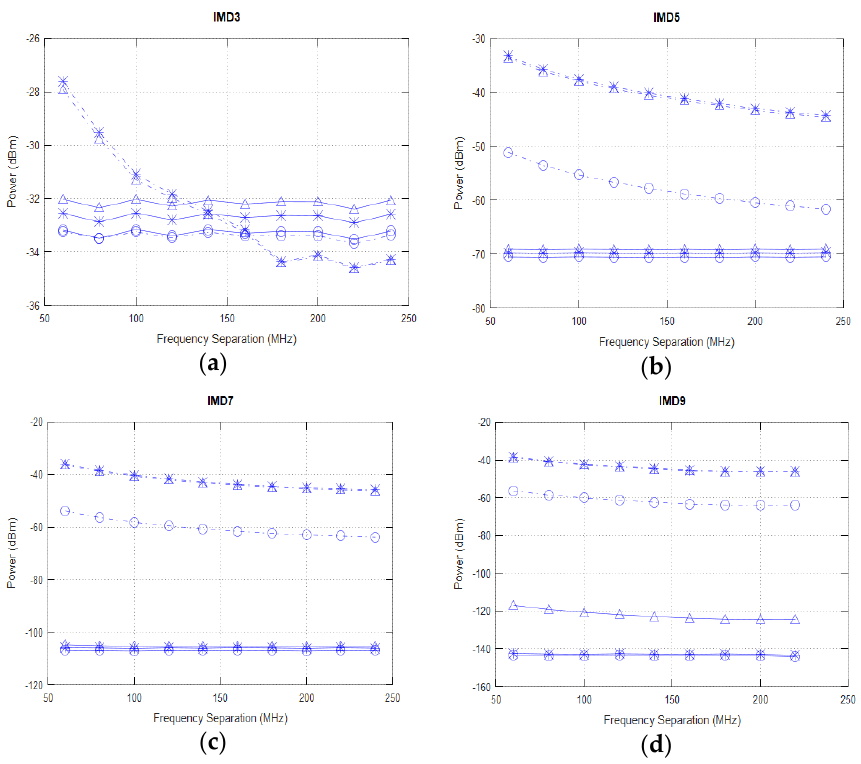
Figure 7. Power in the intermodulation components vs. frequency separation computed from the periodogram with various window functions: Solid o: Hanning window Solid *: Blackman window, Solid ∆ : Blackman Harris window, Dashed o: rectangular window, Dashed *: Hamming window and Dashed ∆ : Kaiser window.